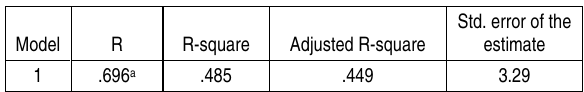
Table 3. Regression and ANOVA of Base Salary and Share Values on